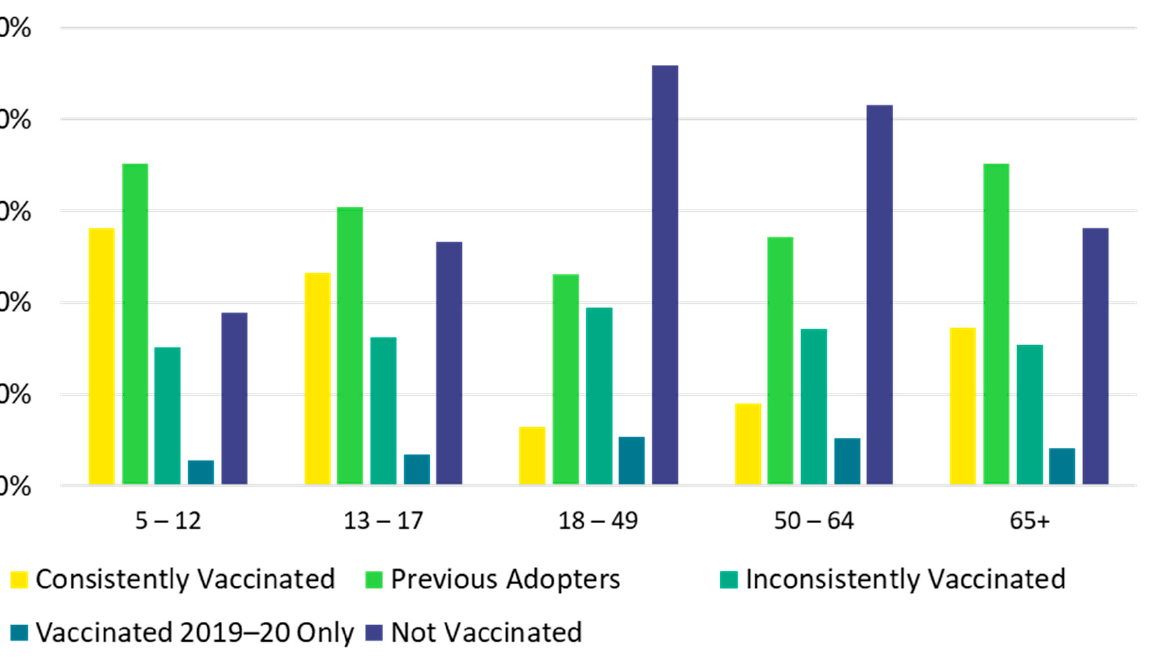
Figure 5. Vaccination history by race. 3.6. Influenza Vaccination Status in the 2020–2021 Season Based on 5-year Vaccination History The study population for part 2 included 138,824 vaccinated individuals (42.7%) and 186,565 unvaccinated individuals (57.3%) in the 2020–2021 influenza season (Table S9). Only the youngest age group (5 to 12 years) had more vaccinated individuals (57.4%) than unvaccinated individuals for the 2020–2021 season. Individuals 18 to 49 years of age had the lowest 2020–2021 vaccination uptake (15.2%). Influenza vaccination status in the 2020– 2021 season was generally consistent with previous vaccination history. Individuals in the not vaccinated cohort were least likely, and those in the consistently vaccinated cohort were most likely, to be vaccinated in 2020–2021 (Figure 6).